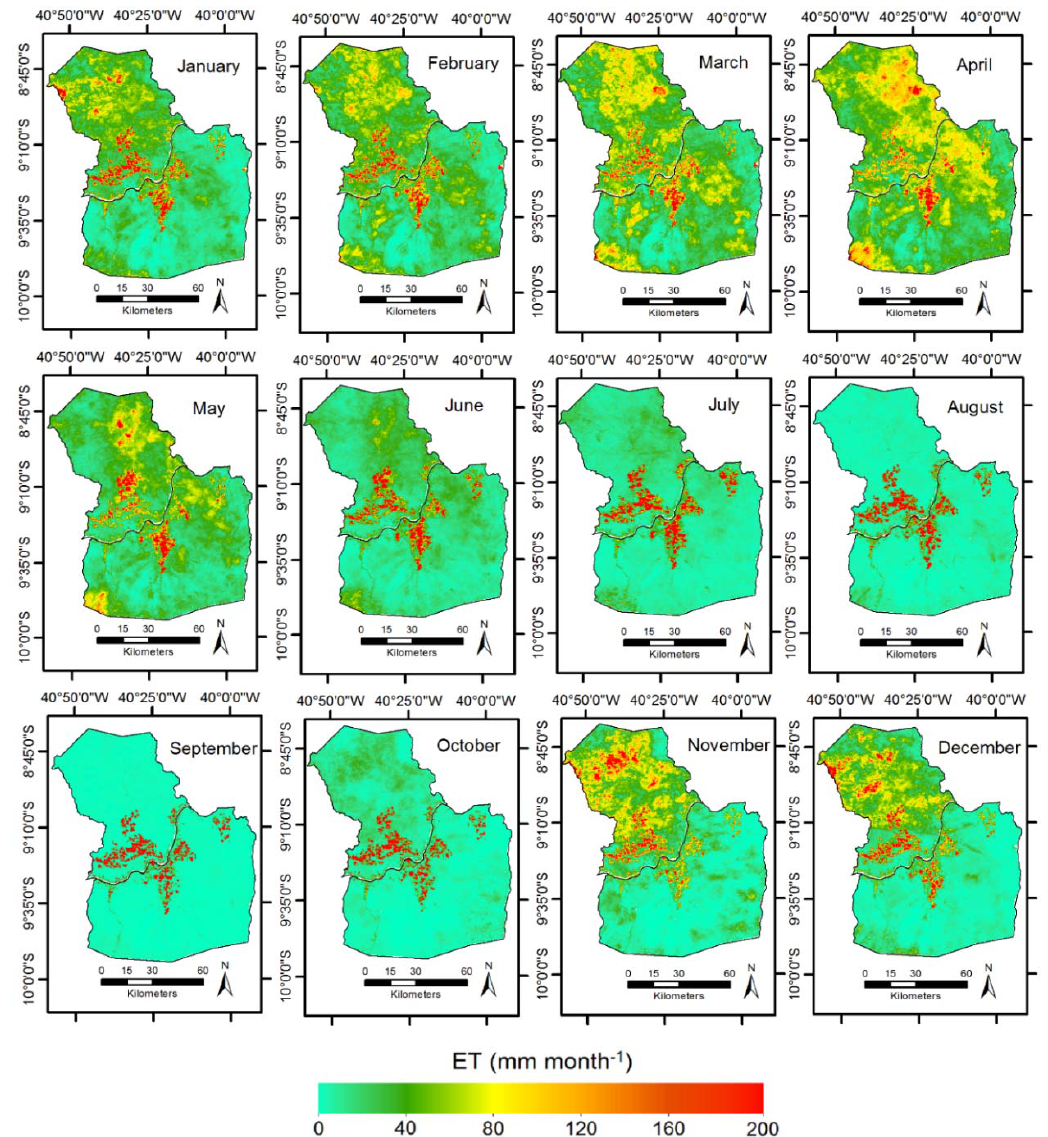
Figure 3. Spatial distribution of the monthly values of actual evapotranspiration (ET) for the mixed agro-ecosystems of Petrolina and Juazeiro municipalities, respectively Pernambuco (PE) and Bahia (BA) states, Brazil, during the year of